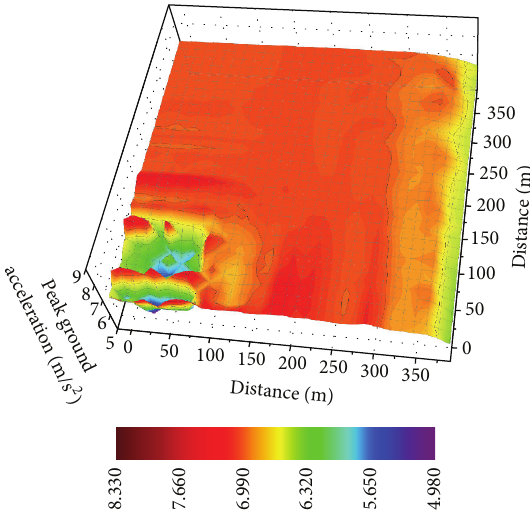
Figure 27: Peak ground acceleration distribution of URBAN6-6 (1/4 FE model, 𝐷 = 0.5 , El Centro, 𝑆𝑋